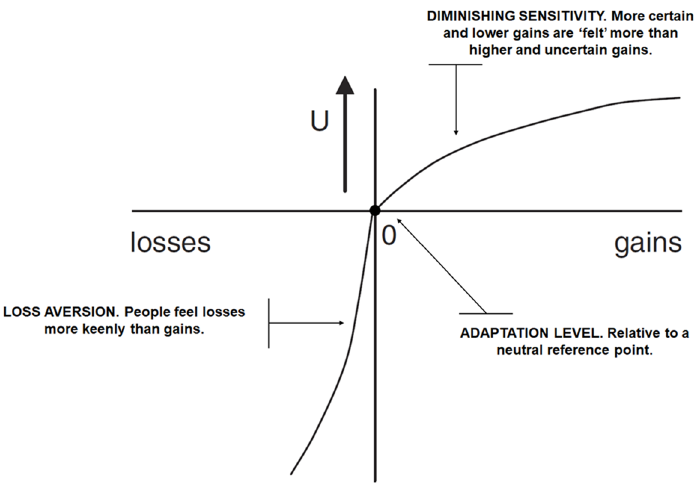
Figure 8. A hypothetical value function, derived from [61], with the reference point at zero.